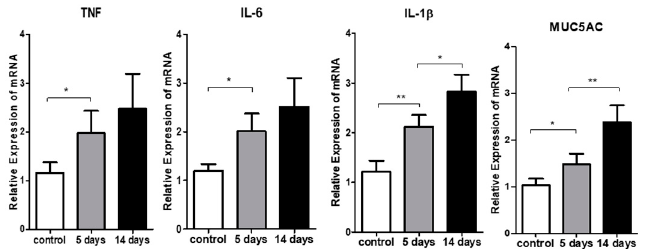
PM 2.5 exposure led to the maturation of APCs in draining LNs as compared to the vehicle controls ( p < 0.05, Figure 4A,B).